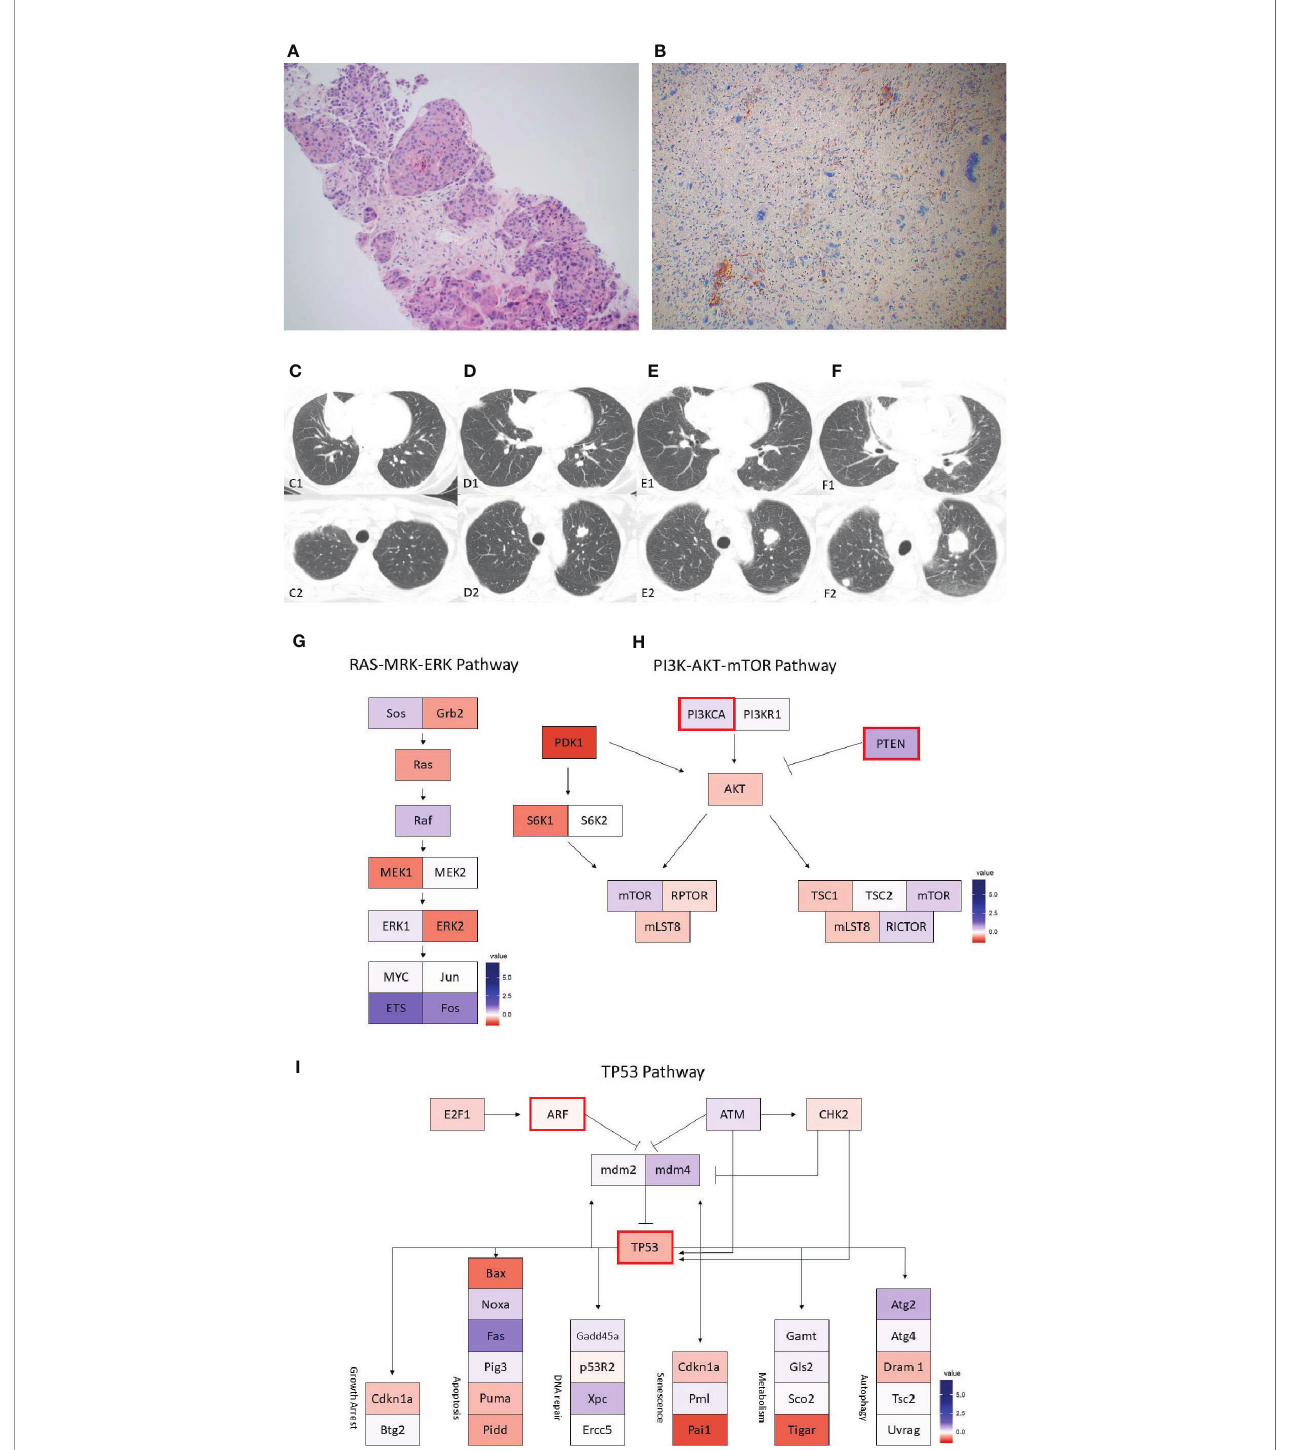
FIGURE 1 | Case 1 (A) H&E image, showing metaplastic carcinoma with chondroid differentiation (B) PD-L1 by the Ventana PD-L1 SP263 assay (C – F) . Radiographic changes in Case 1 from (C) week 0, (D) 12 weeks, (E) 16 weeks, and (F) 24 weeks. Images C1 to F1 showing regression of the dominant right lung mass, then regrowth. Images C2 to F2 showing growth of an initially non-target left lung nodule. Images (G – I) show RNA expression heatmaps with modi fi ed z-scores of expression vs. non-metaplastic TNBC cases in pathways of interest for metaplastic breast cancer (G) RAS-MEK-ERK, (H) PI3K-AKT-mTOR (I) TP53. Genes with DNA mutations are outlined in